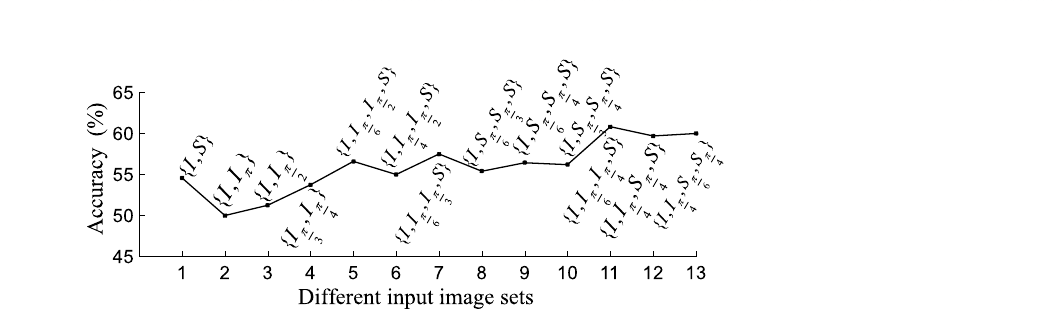
Table 2. Comparison with the state-of-the-art methods on six different standard datasets. Significant values are in [bold].